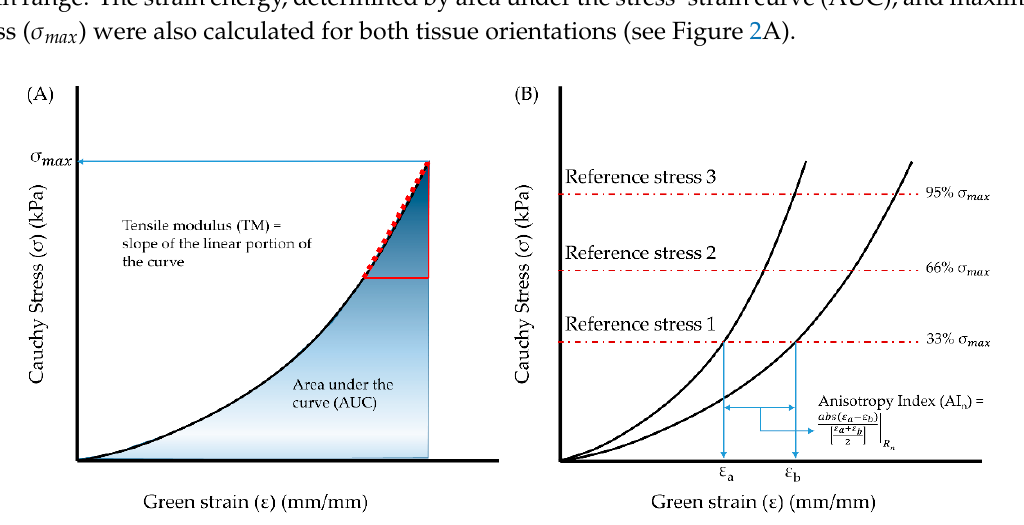
Figure 2. Biomechanical parameters evaluated from the stress–strain curves generated from biaxial mechanical testing of porcine abdominal aorta specimens. ( A ) Schematic for calculation of area under the curve (AUC) and maximum tensile stress ( σ max ). ( B ) Procedure for calculation of anisotropy index ( AI ) at each reference stress level, as reported in [39,40]. The reference stresses for each specimen were calculated by estimating 33rd, 66th, and 95th percentiles of σ max in each stress–strain curve.